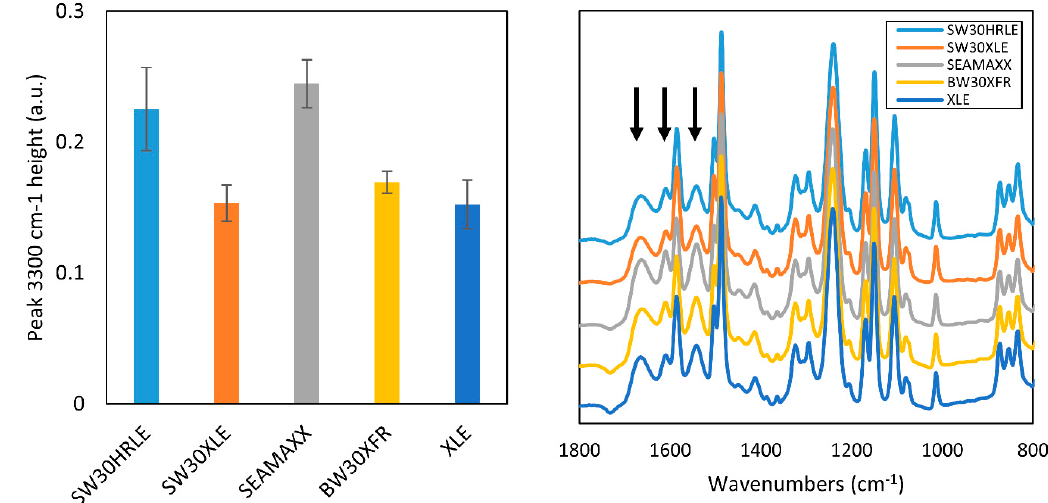
Figure 1. ATR-FTIR spectra of the TFC membranes studies. ( Left ) The peak height of characteristic –OH peak of membrane coatings at 3300 cm − 1 . ( Right ) Characteristic peaks of MPD-TMC-based polyamide layers are highlighted ( black arrows ). Membranes 2019 , 9 , x FOR PEER REVIEW